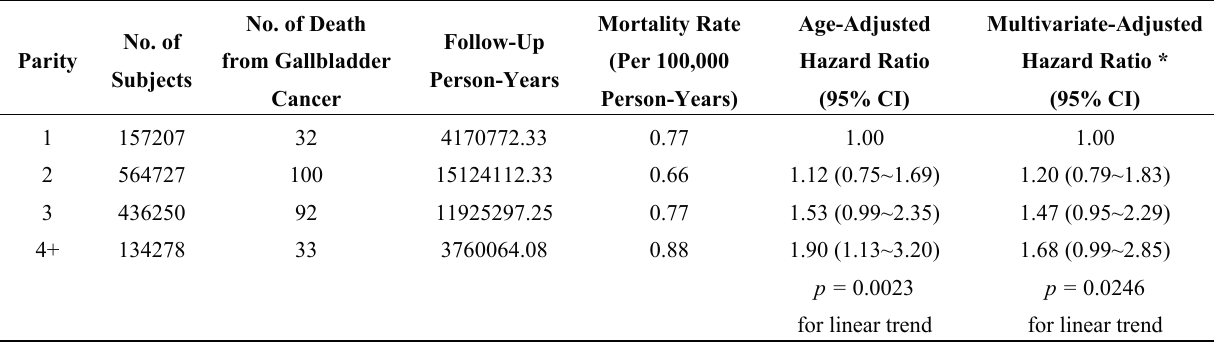
Table 2. Association between parity and hazard ratio of death from gallbladder cancer over a 32-year follow-up